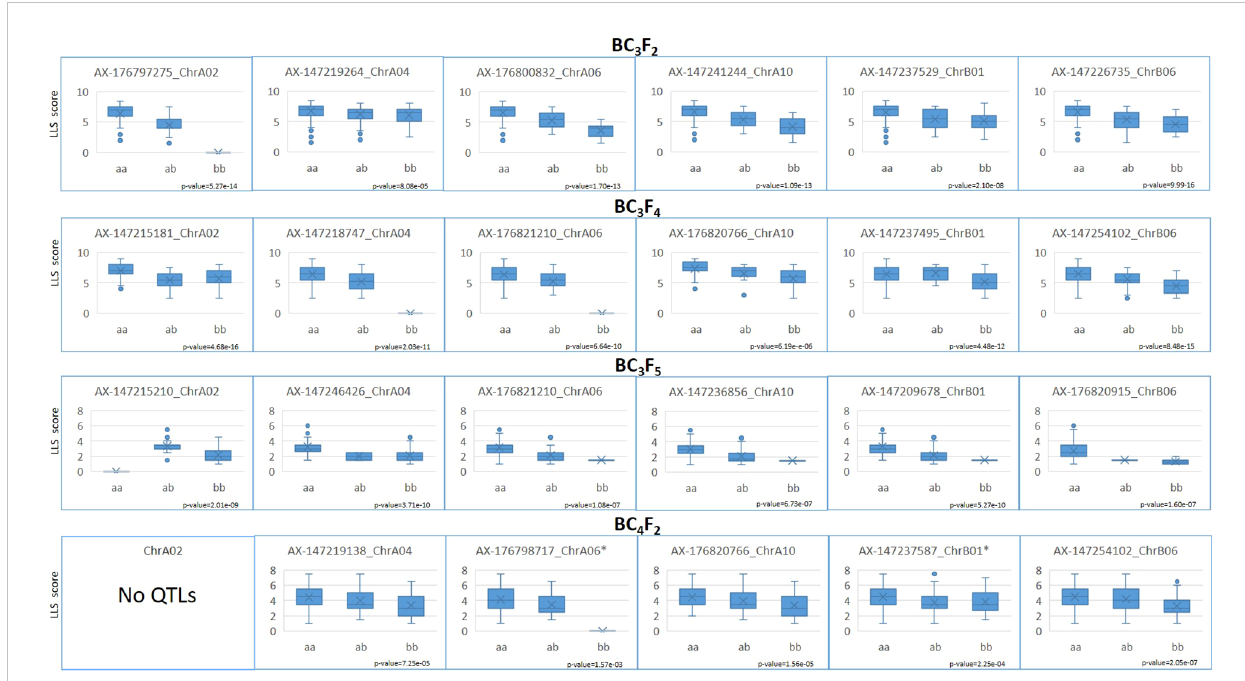
FIGURE 4 Boxplots showing the signi fi cant differences of LLS resistance scores between individuals homozygous for the cultivated (aa) and wild (bb) alleles, and heterozygous (ab) for the nearest loci of QTLs identi fi ed on chromosomes A02, A04, A06, A10, B01, and B06, on populations BC 3 F 2 , BC 3 F 4 , BC 3 F 5 , and BC 4 F 2 . Genotypes not observed are shown as x with a score of 0. No QTL was detected on the chromosome A02 on BC 4 F 2